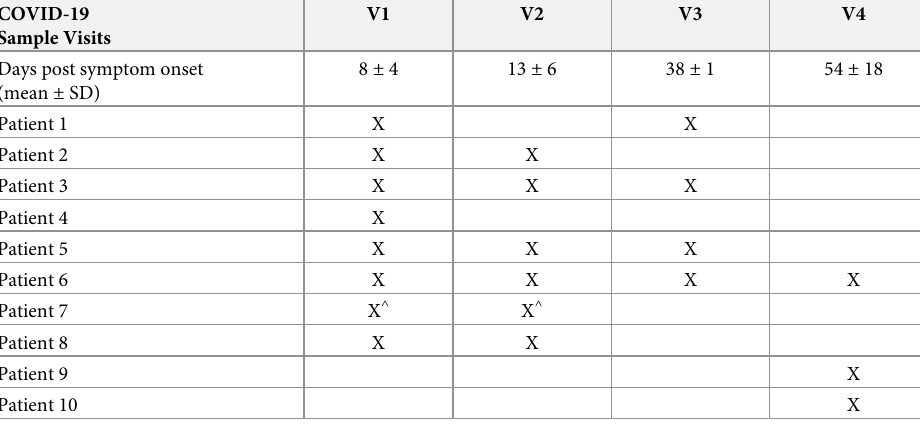
that measurement of three miRNAs (miR-423-5p, miR-23a-3p and miR-195-5p) could iden- tify early-stage COVID-19 with 99.9% accuracy. As patients recovered from disease, the three- miRNA plasma signature returned to that of the healthy controls. The miRNA signature was shown to be robust in the ferret model of COVID-19 and could distinguish SARS-CoV-2 may be adopted to improve COVID-19 detection and patient management.